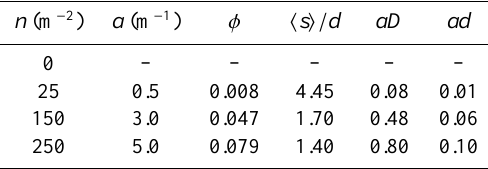
Table 1. Relevant parameters for the studied